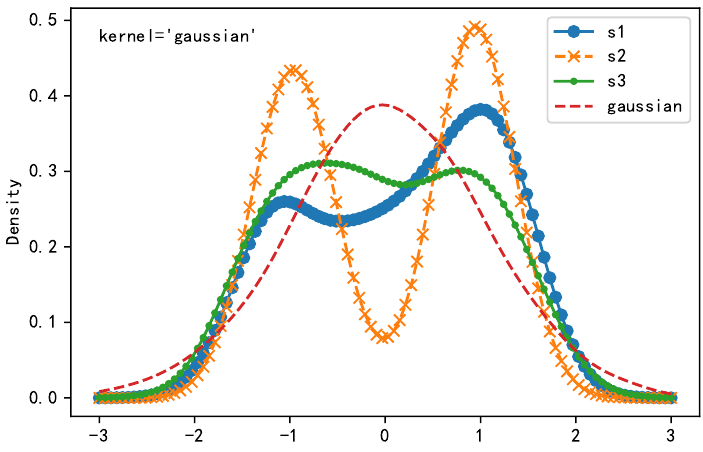
Figure 12. Kernel density estimation of source signals.